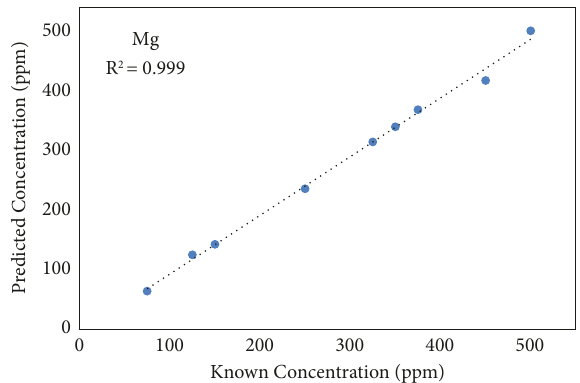
Figure 6: Artificial neural network regression curve of predicted versus known concentration of magnesium.